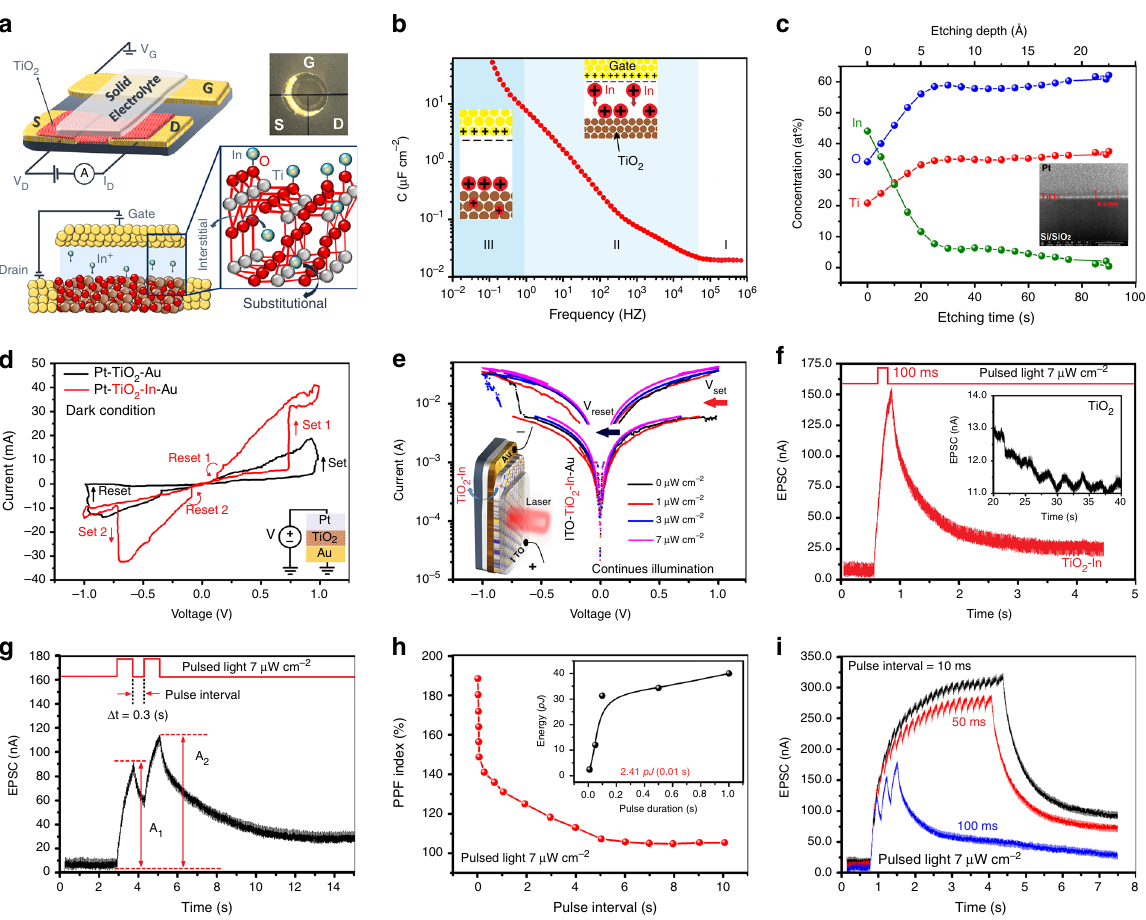
Fig. 2 The characteristics of metal-oxide memristor and optical synaptic device. a The scheme of ion intercalation process in TiO 2 fi lm. b The capacitance- frequency (c-f) graph for In-ion intercalation process. c The XPS surface pro fi le of atomic concentration. d The I-V sweep curves of Pt/TiO 2 /Au and Pt/In- doped TiO 2 /Au memristors under dark and e logarithmic scale I-V curves of Pt/In-doped TiO 2 /Au device under continues illumination of visible lights (530 nm) with various power densities. f The EPSC of TiO 2 and In-doped TiO 2 synaptic devices induced by 7 μ W cm − 2 laser pulses (530 nm) with 100 ms duration. g The EPSC of In-doped TiO 2 synaptic devices induced by two successive 7 μ W cm − 2 laser pulses with 0.3 s intervals. h The variation of PPF index vs. pulse intervals for In-doped TiO 2 synaptic devices. The inset shows the variation of energy of synaptic events per a singular optical pulse (7 μ W cm − 2 ) vs. pulse durations. i EPSC of In-doped TiO 2 synaptic devices stimulated by pulsed lights with various pulse devices 36 . The polarisation of postsynaptic voltage is meaningful, scheme of galinstan droplet. When a galinstan droplet is semi- since it shows that the pulsed light affected the synaptic dynamics submersed into NaOH solution (electrolyte), the surface of and resistive behaviour of optical device allowing the adjustment electrolyte shifts downward in air/solution/galinstan junction of the synaptic responses according to the light intensity and point and decorates a concave interface 38 (scheme in Fig. 4a). It frequency. The effect of light frequency on EPSC, EPSP and happens since the surface energy of galinstan/solution ( δ GS ) is conductance of optical synaptic device are, respectively, depicted higher than that of galinstan/air ( δ GA ) and that of solution/air ( δ SA ) 38 . The tie-line in Fig. 4a shows the boundary between the galinstan droplet and the NaOH solution. From the charge distribution point of view, the surface of immersed part of galinstan droplet in NaOH solution is negatively charged. Consequently, the positively charged ions are accumulated at the diffuse electric double layer (EDL) at galinstan/NaOH solution interface 39 . At the absence of the external potential, the initial charges ( q 0 ) are distributed uniformly throughout the interface. The amplitude of q 0 is related to the electrolyte concentration and the size of galinstan droplet. By applying a singular external potential, the galinstan/NaOH system acts as an electrolyte cell. When a PSP pulse is applied to galinstan droplet (scheme in Fig. 4b), the charge distribution on the droplet surface will stay uniform, which is facilitated by the high conductivity of galinstan 39 . However, since the conductivity of electrolyte is limited, a potential gradient will be expanded throughout the